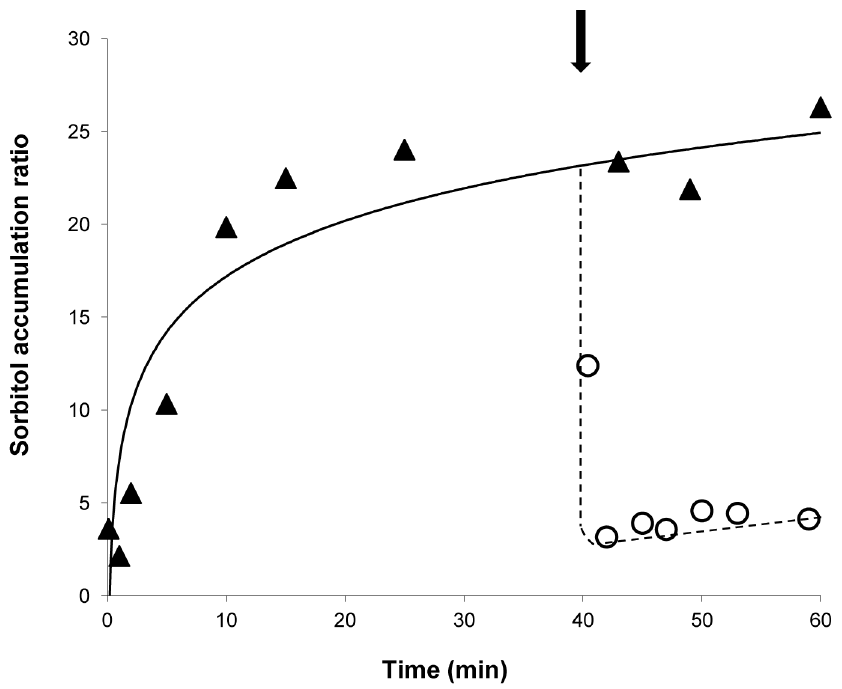
Figure 5. Effect of CCCP on sorbitol accumulation in S.cerevisiae MLY9. Accumulation of [U- 14 C] sorbitol (0.1 mM) by S. cerevisiae MLY9 cells ( m ) grown on maltose medium. The arrow indicates the addition of 0.25 mM CCCP ( #